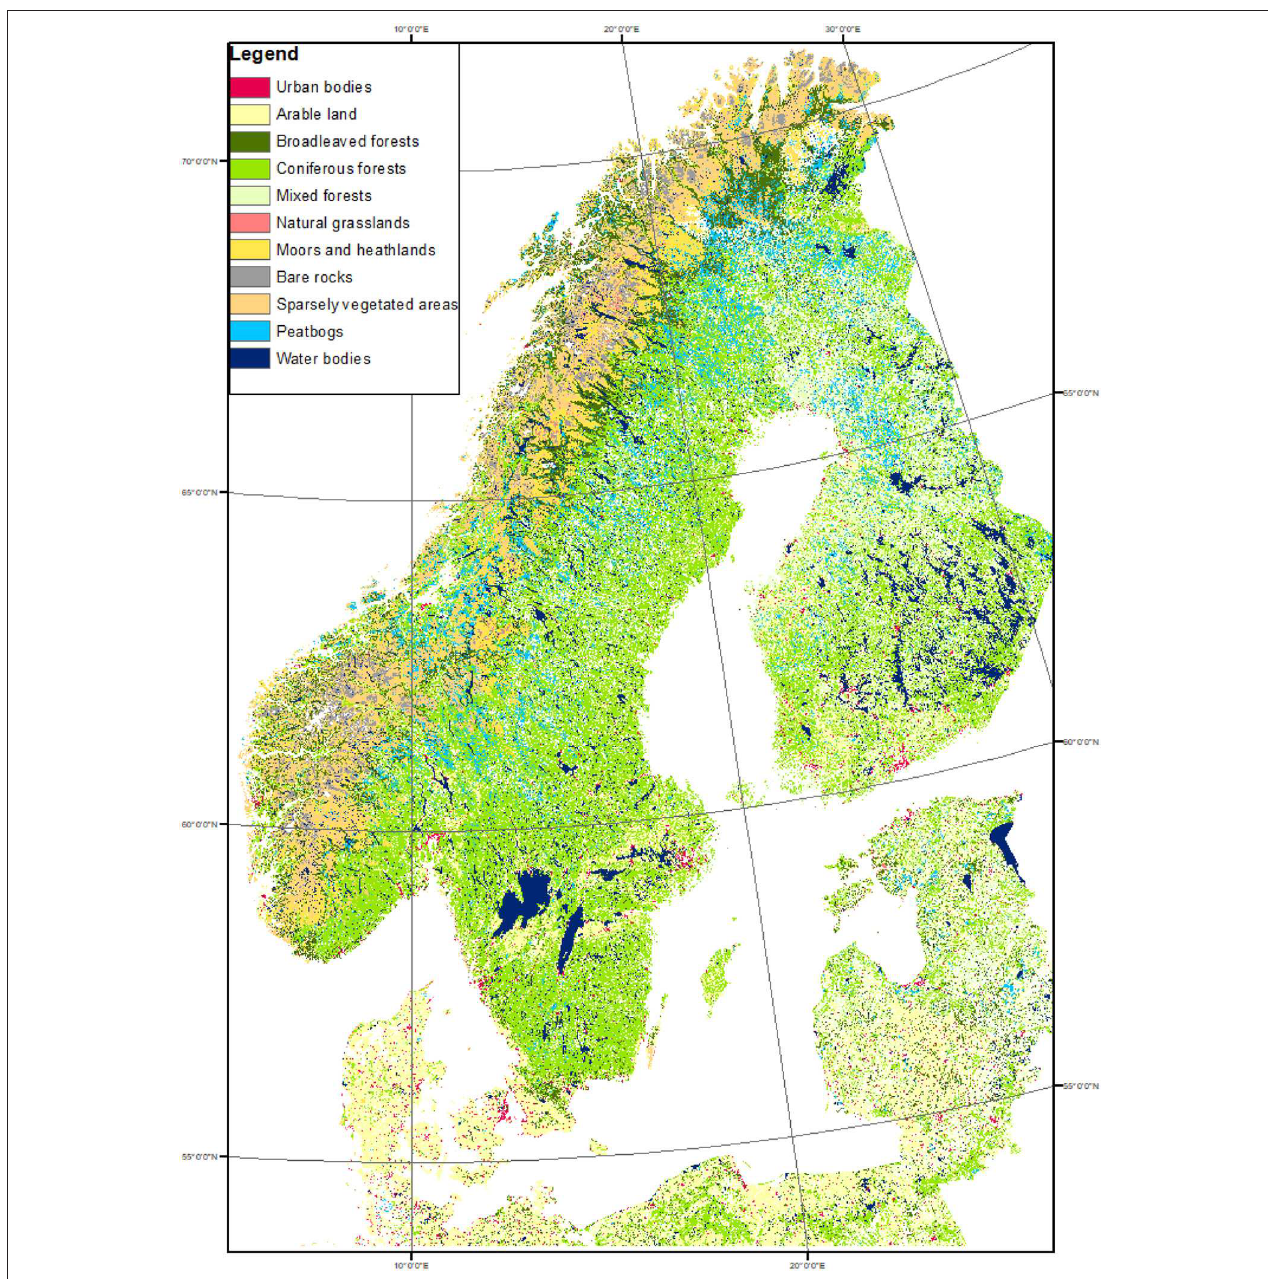
FIGURE 1 | Scandinavian land-use map extracted from CORINE (2012). The statistical analyses were performed in all pixels classified as forest (broad-leaved, coniferous, and mixed forests; green shades).